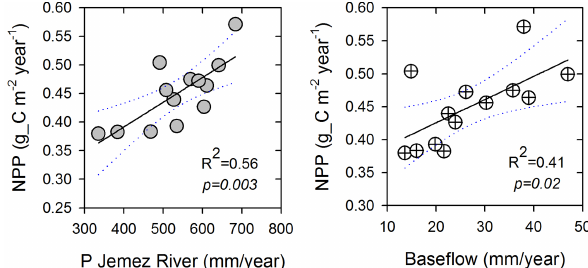
Figure 3. (a) Positive linear correlation between precipitation in the upper JRB and annual NPP in the upper JRB-derived from MODIS; (b) linear correlation between baseflow and annual NPP in the upper JRB. Forest productivity is water limited in the upper JRB. Other variables such as annual, winter, and summer air temperature did not correlate with